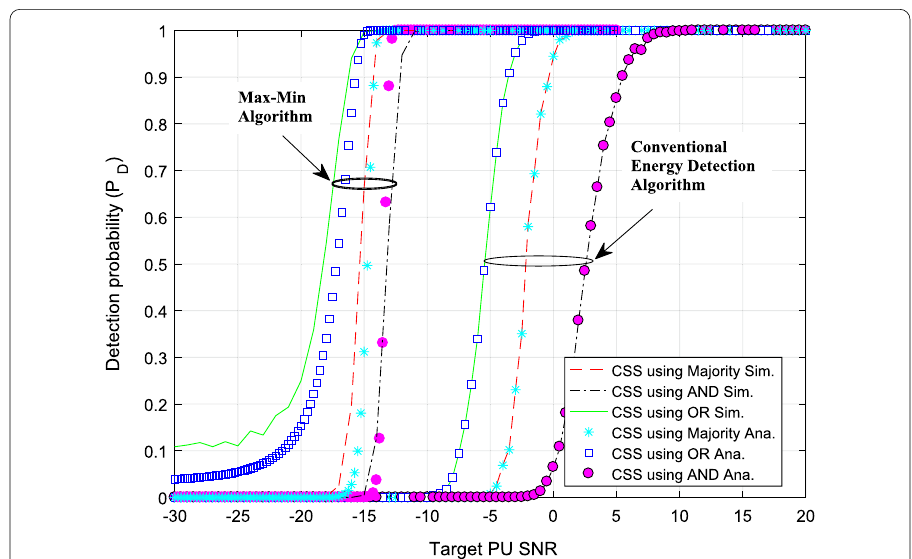
Fig. 11 Comparison of detection probabilities between traditional ED and Max–Min ED with three different linear fusion rules for 2x-oversampled QPSK PU signal under Indoor channel and log-normal fading ( σ = 9dB ), the length of N FFT = 32 , the number of sensing stations M complexity N 20,480, and 1 dB NU =